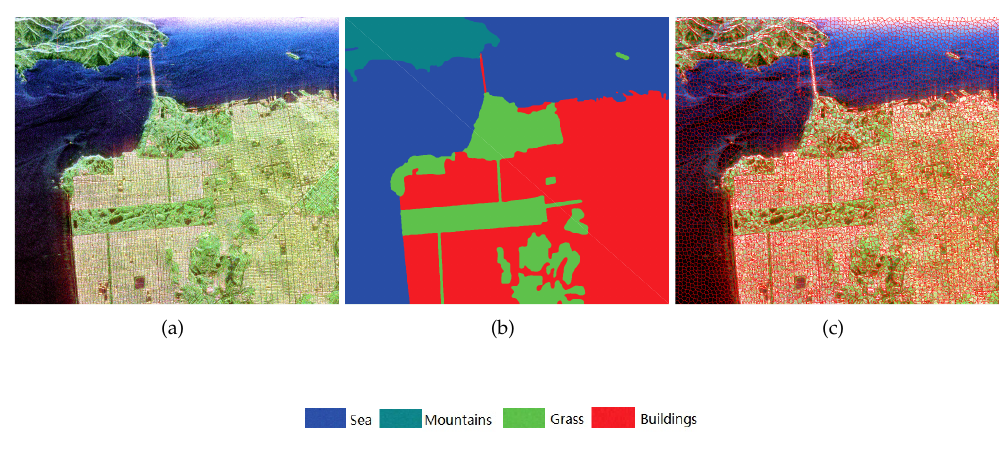
Figure 4. Display of the San Francisco Bay data set. ( a ) the PauliRGB image, ( b ) the corresponding ground truth and ( c ) the segmentation